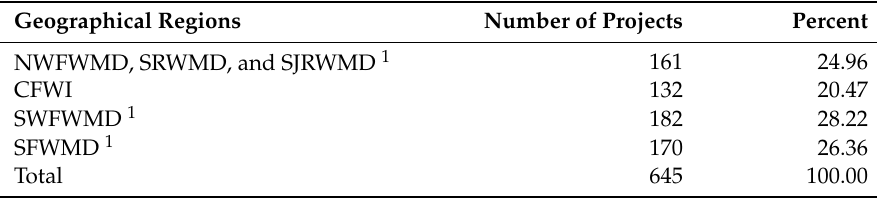
Table 3. Project number, by geographical region.